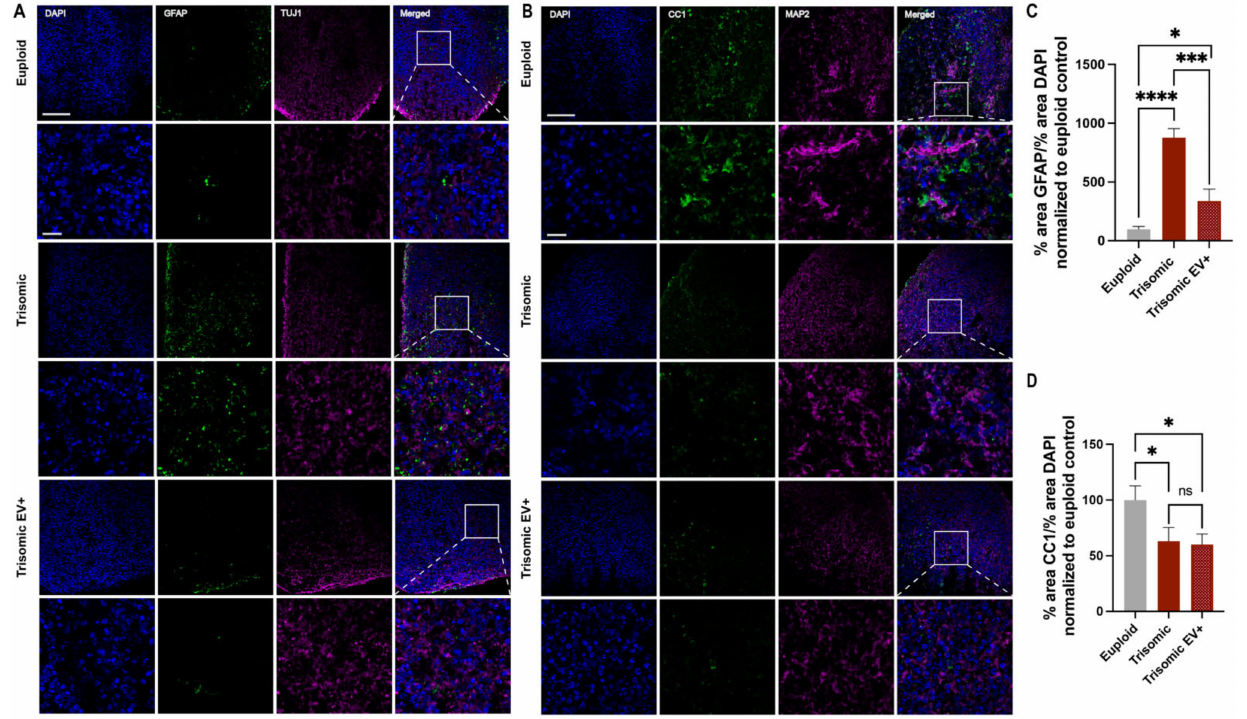
Figure 4. The effect of EV treatment on astrocyte and oligodendrocyte populations in trisomic CS. ( A ) Single and merged channels of confocal images showing DAPI staining (blue) with IHC labeling of GFAP (green) and TUJ1 (magenta) in euploid and trisomic untreated and EV-treated CS generated from isogenic cell lines. ( B ) Single and merged channels of confocal images showing DAPI staining (blue) with IHC labeling of CC1 (green) and MAP2 (magenta) in euploid and trisomic untreated and EV-treated CS generated from isogenic cell lines. Top panels in A and B show low magnification images, scale bar = 100 µ m. White boxes represent high magnification insets in bottom panels, scale bar = 20 µ m. ( C ) Bar graphs showing the quantification of the percentage of GFAP expression and ( D ) the percentage of CC1 expression in euploid CS and trisomic untreated and EV-treated trisomic CS. The percentage of each marker was quantified as the ratio of the area occupied by the label (GFAP or CC1) to the area occupied by DAPI in each image and normalized to the euploid control that was calculated as 100% for each independent experiment. The quantification was performed through particle analysis via ImageJ; euploid, n = 18; trisomic, n = 22; trisomic EV+ n = 22 CS per group. These graphs display results from three independent experiments. Statistical analysis was performed via unpaired t -test with Welch’s correction comparing all three groups to each other. Results are shown as mean ± SE. * p < 0.05, *** p < 0.001, **** p < 0.0001, ns =